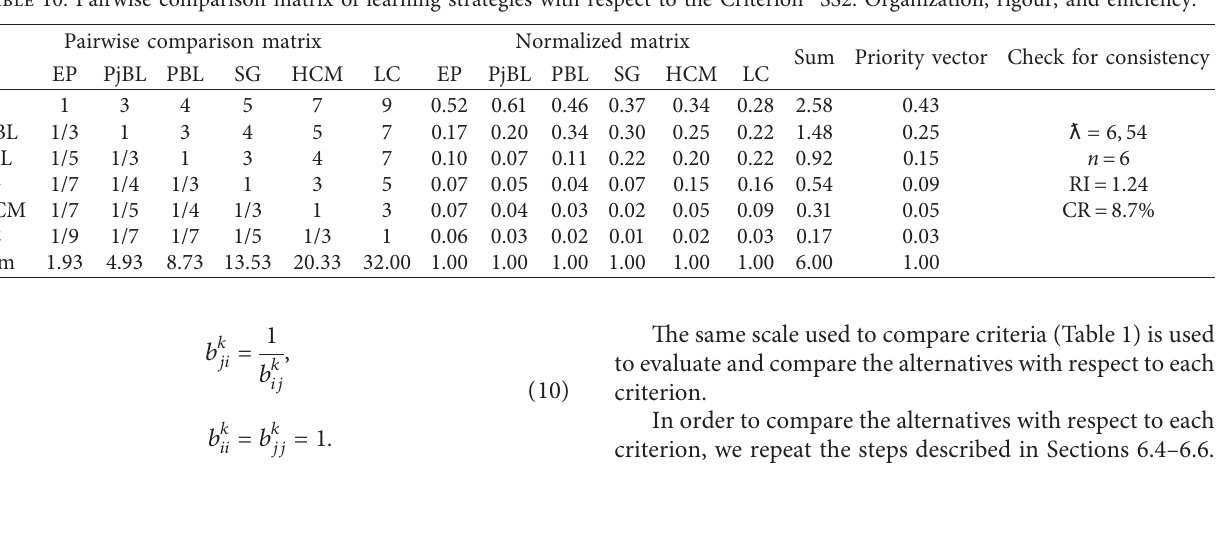
Sum Priority vector Check for consistency